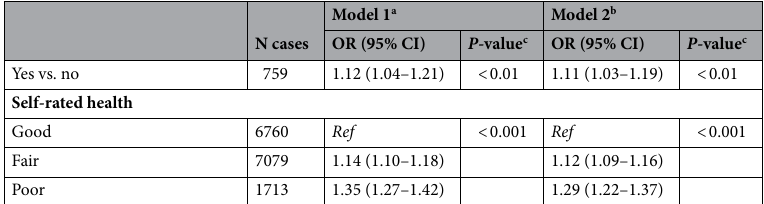
Table 2. Odds ratios and 95% CI for baseline factors by Hepatitis B surface antigen status. BMI, body mass index; MET, metabolic equivalent of task; NS, not significant. a Adjusted for age in 5-year categories, sex and study site (ten sites) where possible, b Adjusted for age in 5-year categories, sex and study site (ten sites), birth cohort, education, occupation, household income, number of years with a household fridge, alcohol intake, history of blood transfusion, body mass index and self-rated health where possible, c p trend presented for ordered categorical variables, d Other occupation includes house-wife/husband, self-employed, unemployed, other or